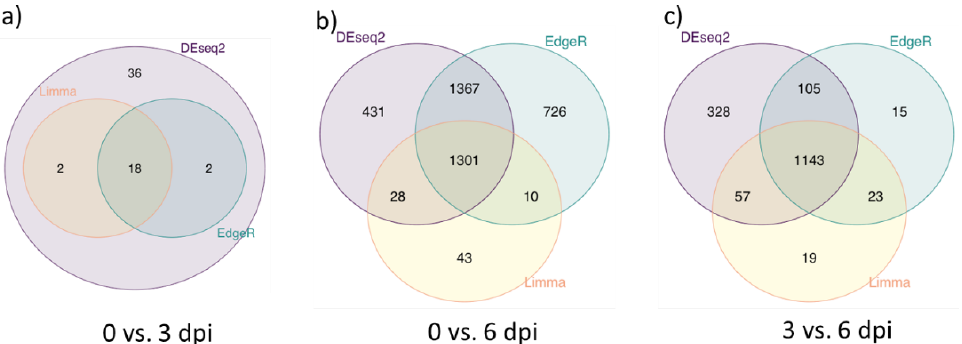
Figure 2. Differential gene expression analyses across 3 pairwise comparisons using 3 different methods. Venn diagrams of the differentially expressed genes (DEGs) in PBMCs from pigs collected at 0 dpi, 3 dpi and 6 dpi. ( a ) Venn diagram showing the overlap between the DEGs identified by the DEseq2, glmQL for EdgeR and Limma packages (see Materials and Methods) shown in lilac, blue and yellow, respectively, between PBMCs from the uninfected (0 dpi) and infected pigs at 3 dpi. ( b ) Venn diagram of the DEGs detected by these same packages between the PBMCs from uninfected pigs (0 dpi) and from infected pigs at 6 dpi. ( c ) Venn diagram of the DEGs between PBMCs collected from pigs at 3 and 6